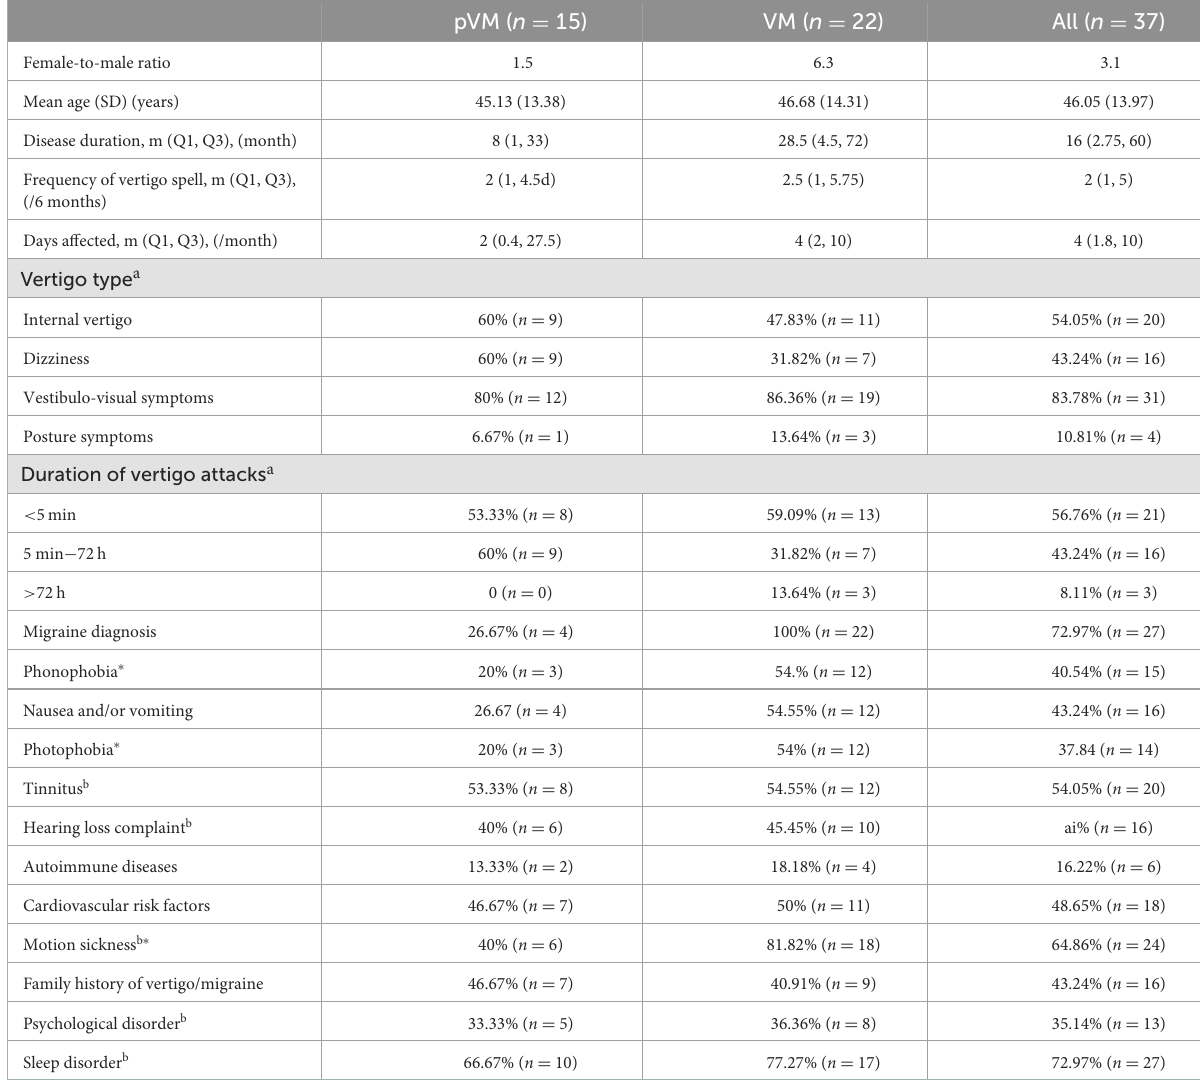
TABLE 1 Clinical characteristics of patients with probable vestibular migraine (pVM) and vestibular migraine